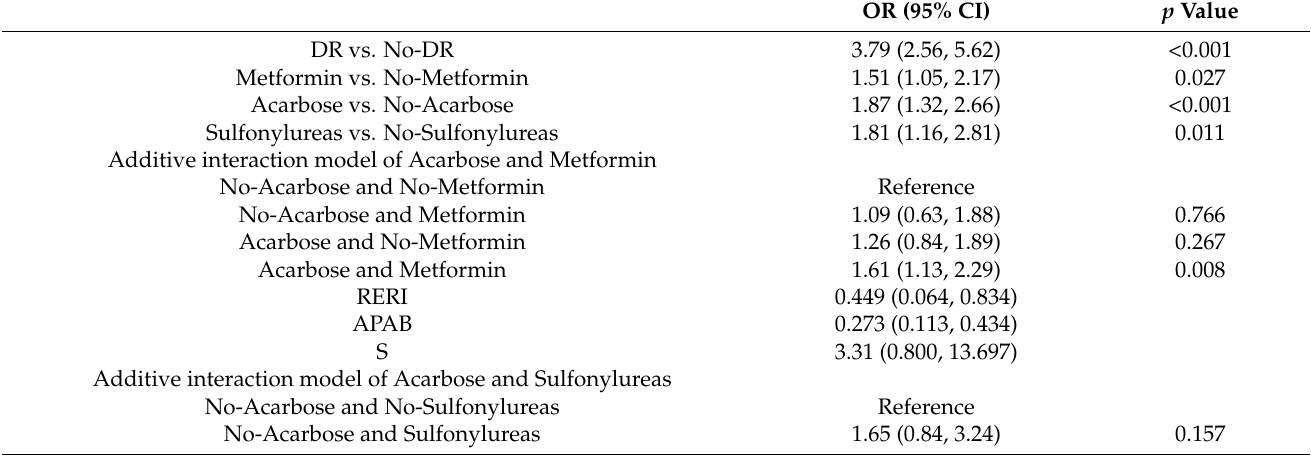
Table 4. Interactive effects between different oral hypoglycemic drugs and DR for DN